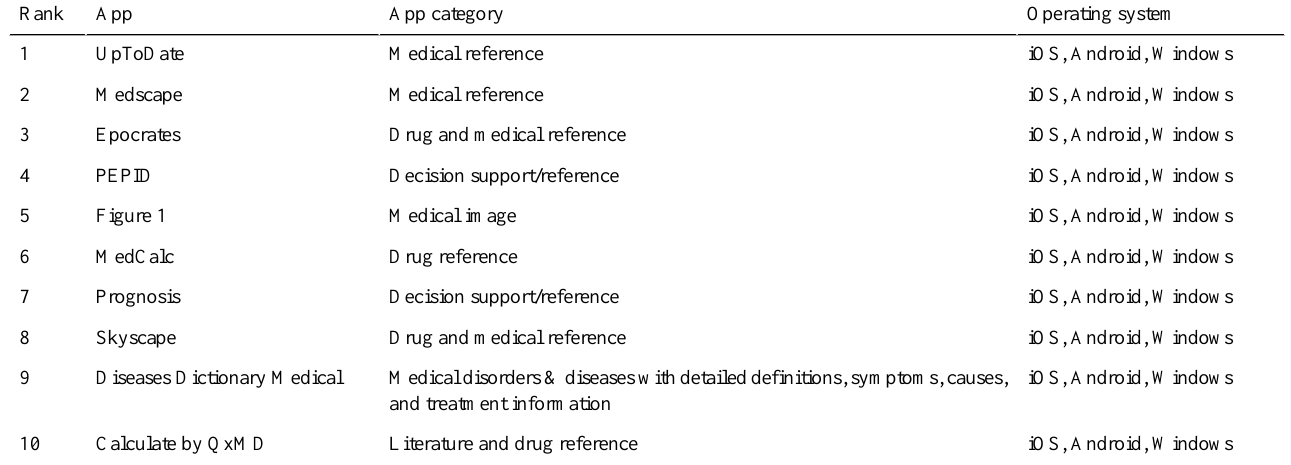
Table 1. Summary of the most commonly used smartphone medical apps.